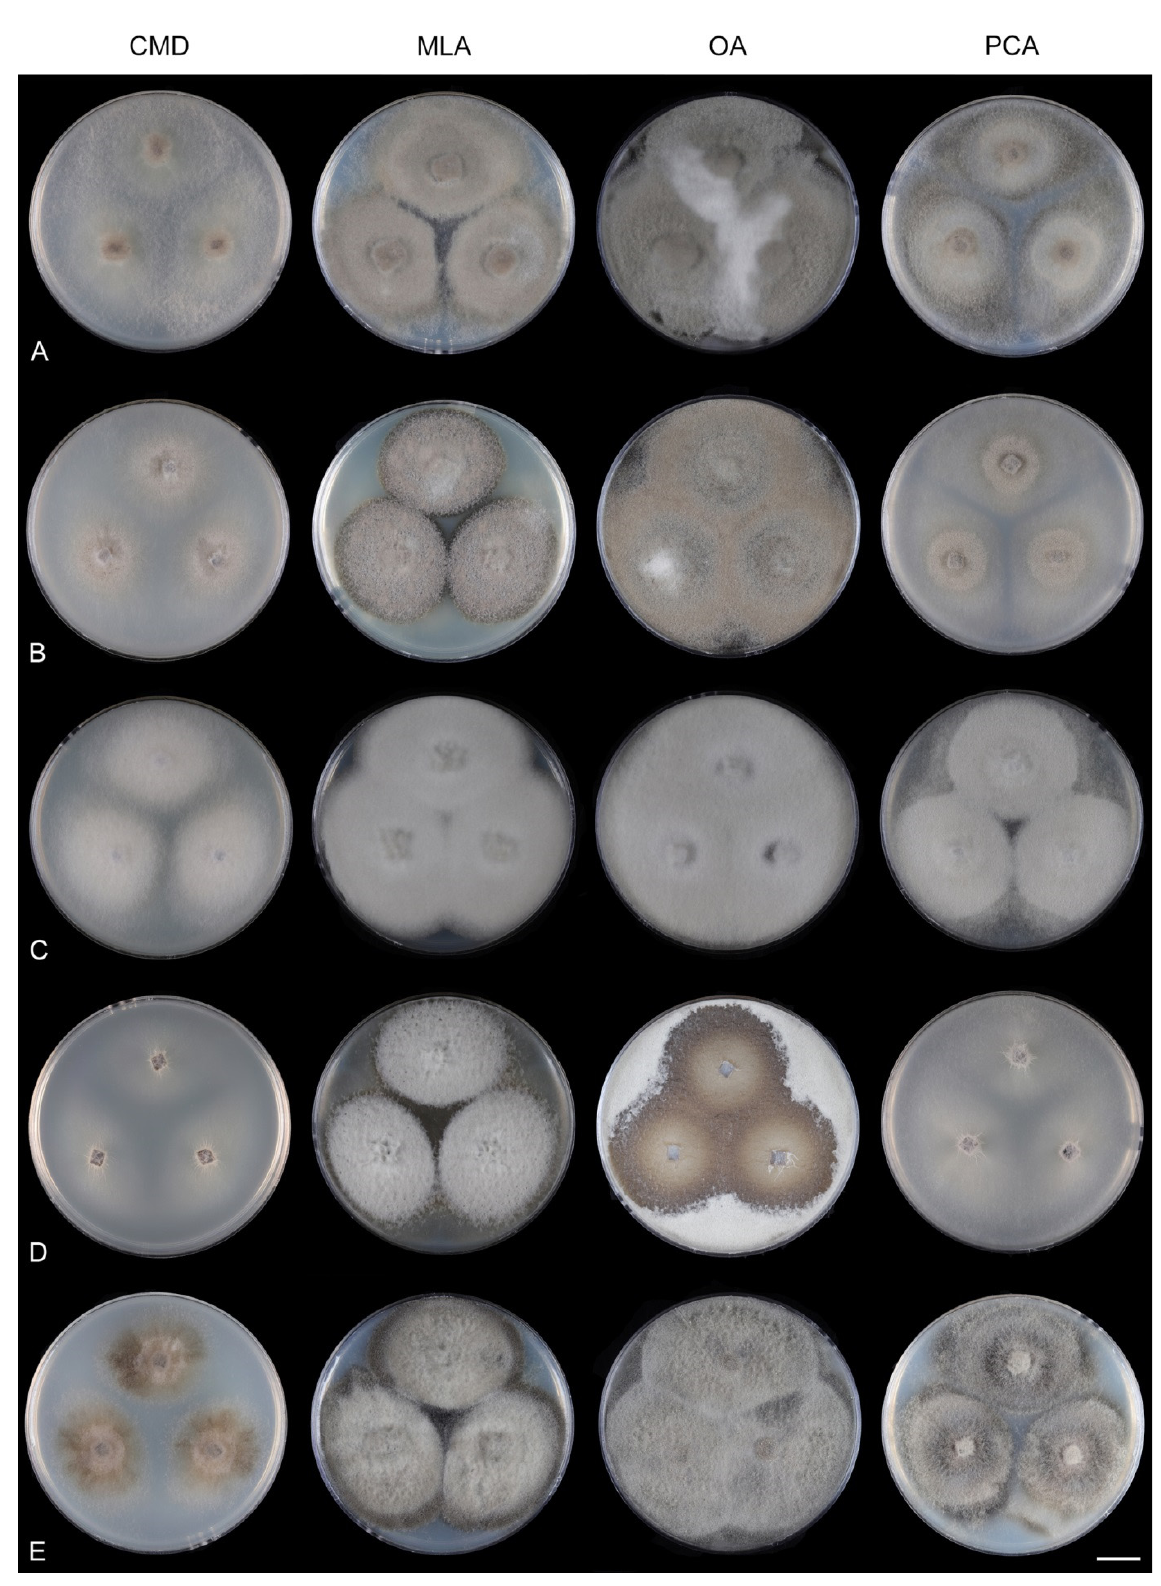
Figure 13. Colony morphology of Codinaea spp. after 4 weeks. ( A ) C. assamica CBS 139907 ex-type of C. acaciae ( B ) C. fertilis IMI 233824 ( C ) C. fertilis MUCL 15427 ( D ) C. dwaya CBS 261.77 ex-type ( E ) C. siamensis CBS 194.96. Scale bar: ( A – C ) 1 cm.